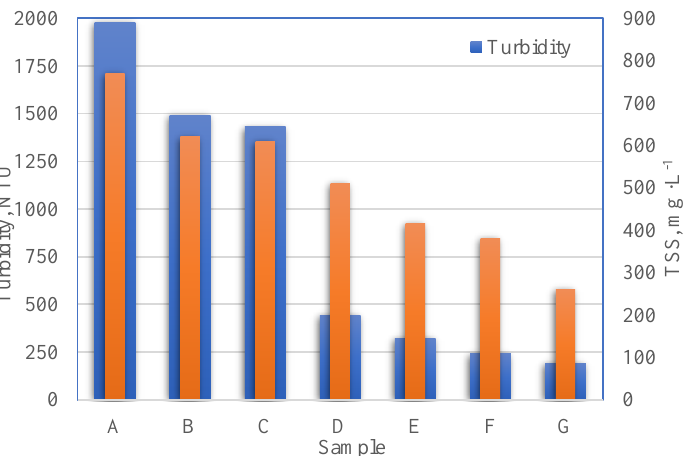
Figure 4. Comparison of parameter values of suspension and turbidity in the raw sewage and after the application of preliminary treatment (sedimentation, bag filter, centrifugation 5 – 30 min).